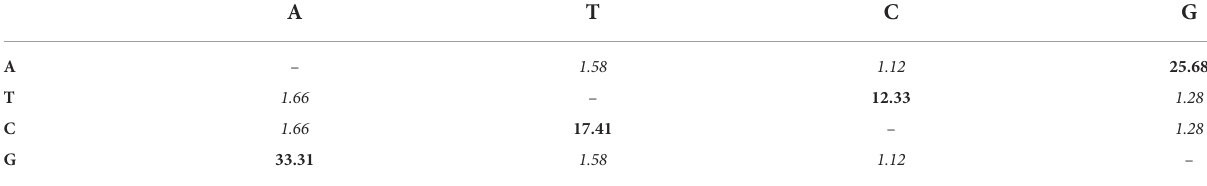
TABLE 9 Maximum composite likelihood estimate of the pattern of nucleotide substitution.